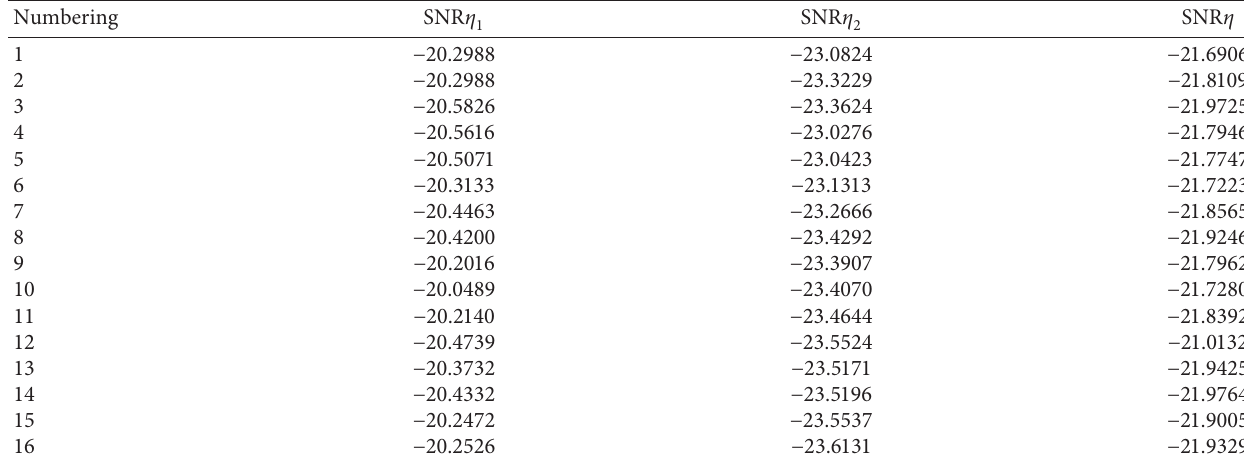
Figure 12: A1B1C4D4E1 combined simulation results with (a) warpage and (b) volume shrinkage. Table 11: SNR calculation